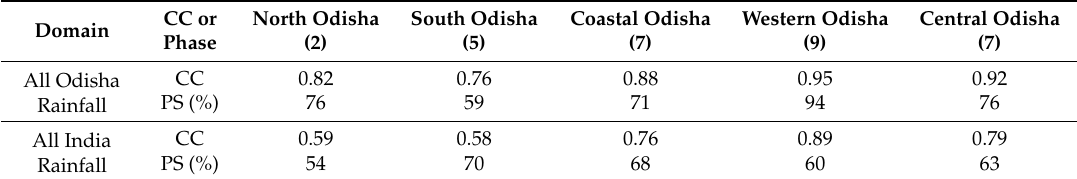
Table 4. The phase and CC analysis of rainfall in different regions of Odisha with respect to all of Odisha and all of India rainfall. The analysis was carried out for the period 1951–2013.